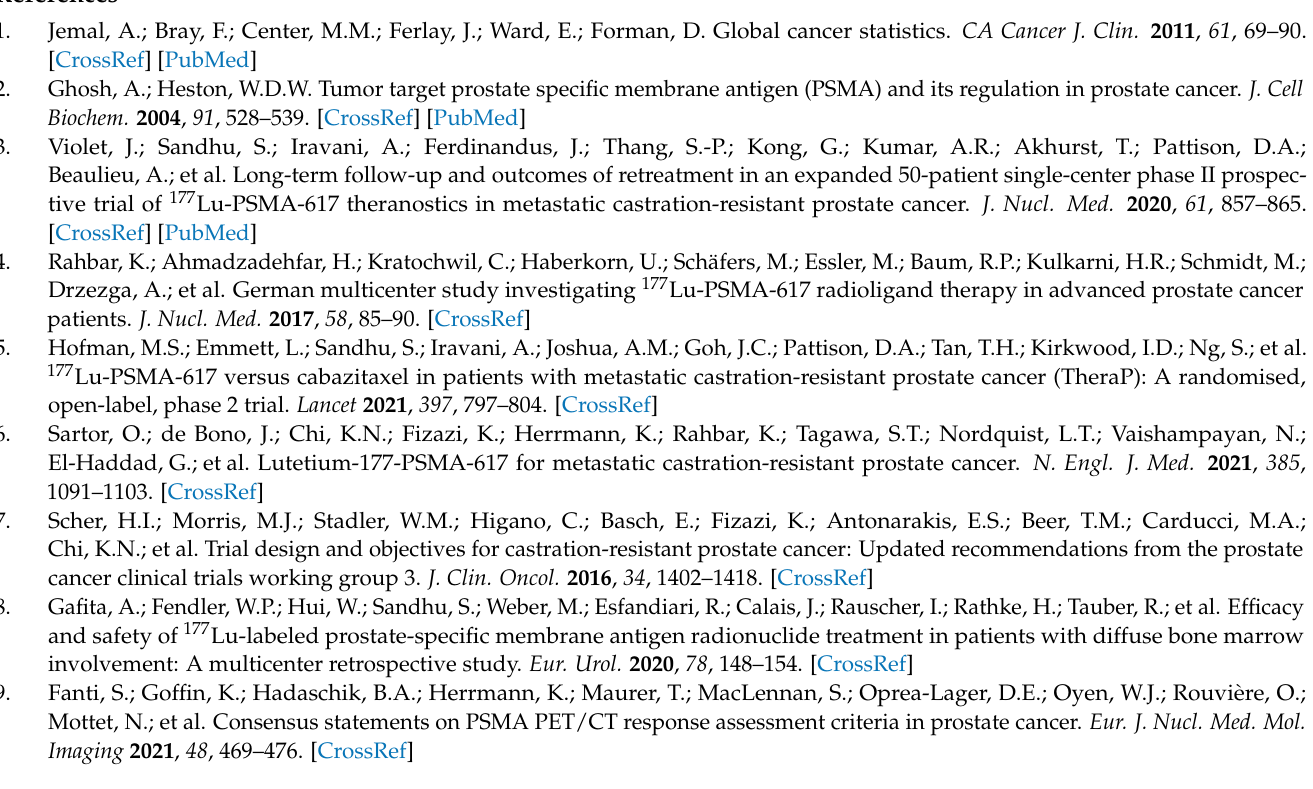
Supplemental Table S2: Results of univariate linear regressions of various pretherapeutic variables with changes in the PSA during restaging after two cycles of [ 177 Lu]PSMA-617 radioligand therapy. Supplemental Table S3: Correlation between the early changes in PSA four weeks after baseline (first administration of PSMA-RLT) and the biochemical response during restaging after two cycles of [ 177 Lu]PSMA-617 radioligand therapy, using a threshold of early PSA decrease of 50% compared to the baseline ( ∆ %PSA ≤ −